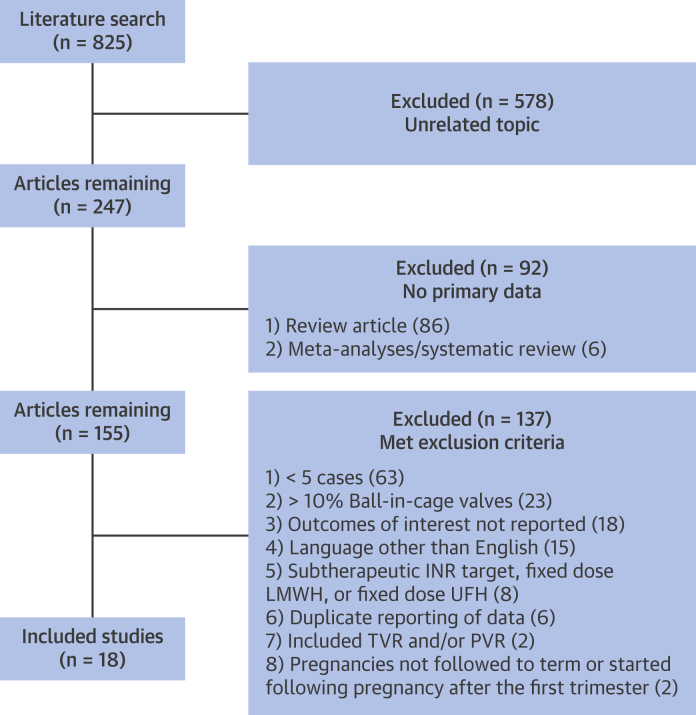
Study Search FlowchartThe number and types of studies captured by the search terms. INR = international normalized ratio; LMWH = low-molecular-weight heparin; PVR = pulmonary valve replacement; TVR = tricuspid valve replacement; UFH = unfractionated heparin.